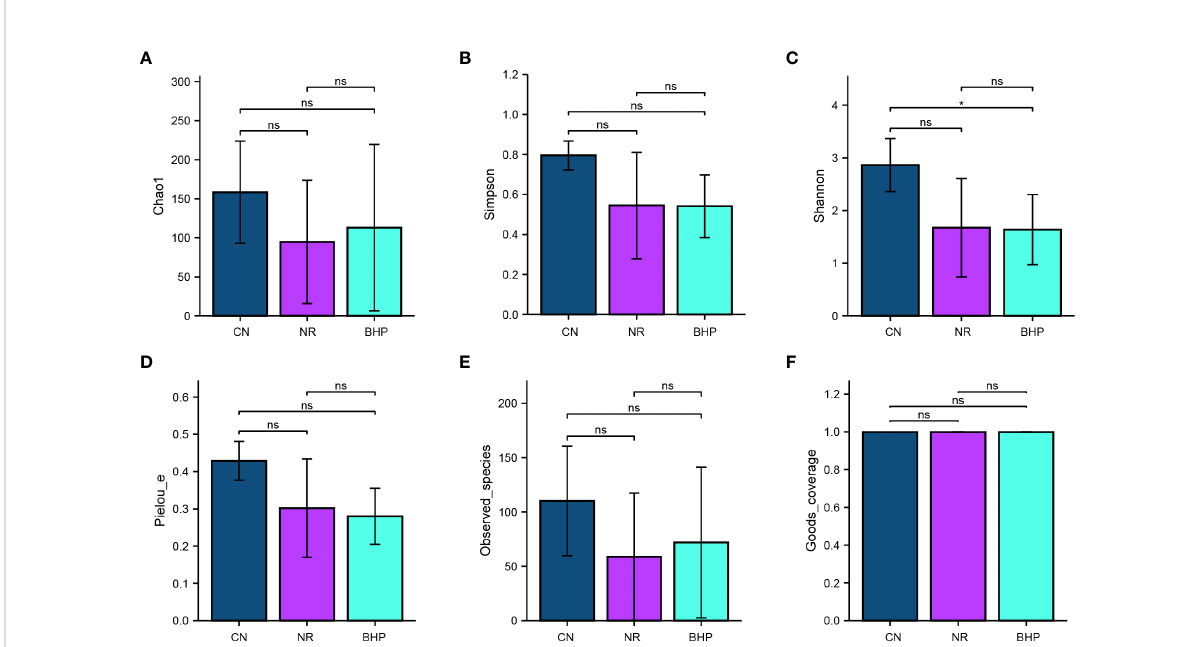
FIGURE 5 Alpha diversity index of the lactase-producing bacteria from the intestinal contents in each group. (A) : Chao1. (B) : Simpson. (C) : Shannon. (D) : Pielous evenness. (E) : Observed specie. (F) : Goods coverage. Chao1 and Observed species indices represent community richness, Shannon and Simpson indices represent community diversity, Pielou ’ s evenness index represents community evenness, and Good ’ s coverage index represents the percentage of detected species in the sample. *: P < 0.05. CN, control group; NR, natural recovery group; BHP, Baohe pill decoction treatment group ns: P ≥